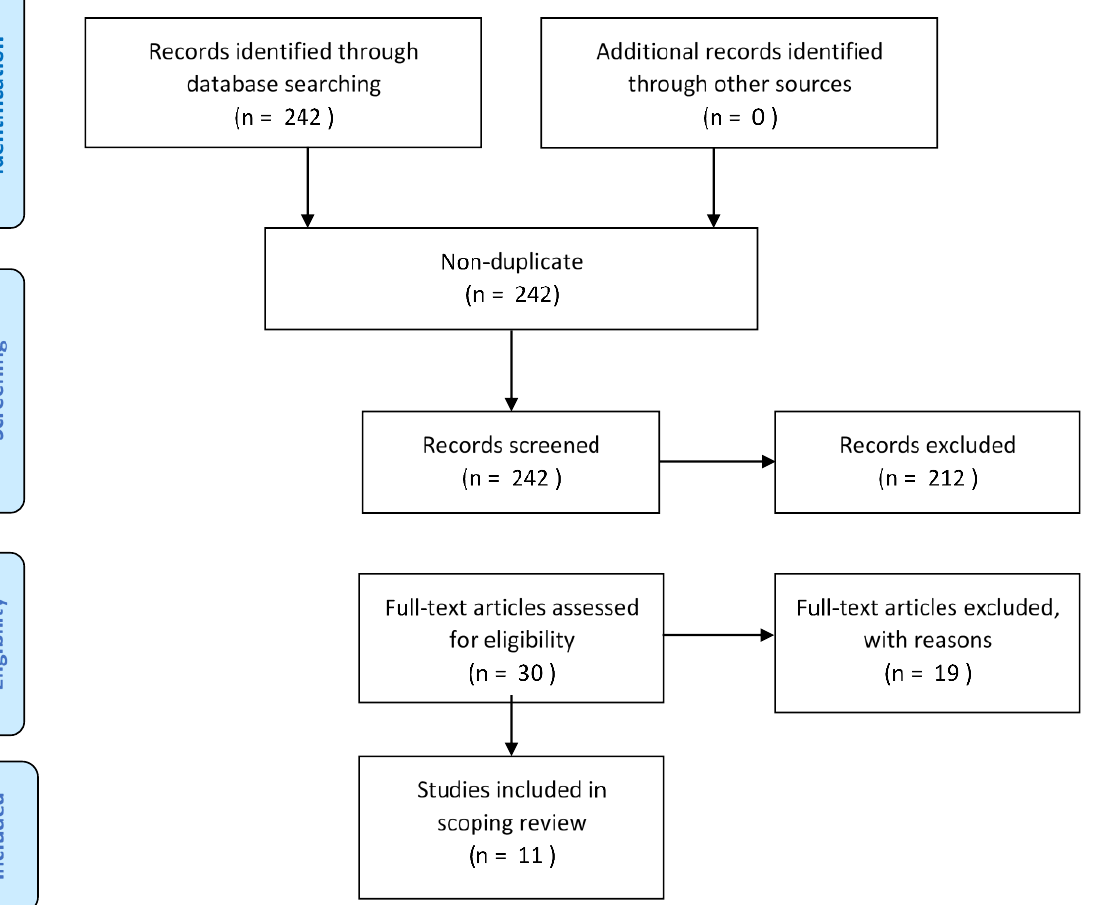
Figure 1. Flowchart of study selection [20]. From: Moher D, Liberati A, Tetzlaff J, Altman DG, The PRISMA Group (2009). Preferred Reporting Items for Systematic Reviews and Meta-Analyses: The PRISMA Statement. PLoS Med 6(7): e1000097. doi:10.1371/journal.pmed1000097.